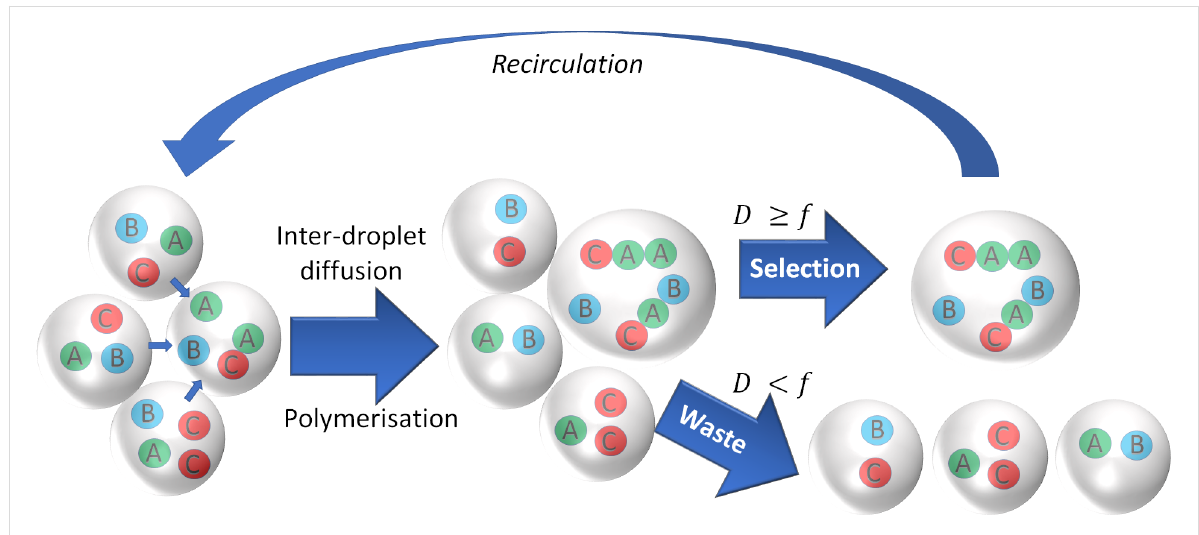
Figure 3: Recursive size-based selection and recirculation of droplets. Monodisperse droplets loaded with complex autocatalytic chemical networks are incubated in the microfluidic device. Those droplets which facilitate the fastest production of high molecular weight polymers from simple precur- sors exhibit an increase in osmolarity and subsequently grow in size at the expense of neighbouring droplets. Size sorting is then used to select for droplets with a diameter ( D ) above a size threshold for droplets to be used in the next generation ( f ). Those droplets are recirculated into the next generation, replenished with fresh feedstock, and the process is repeated in an iterative